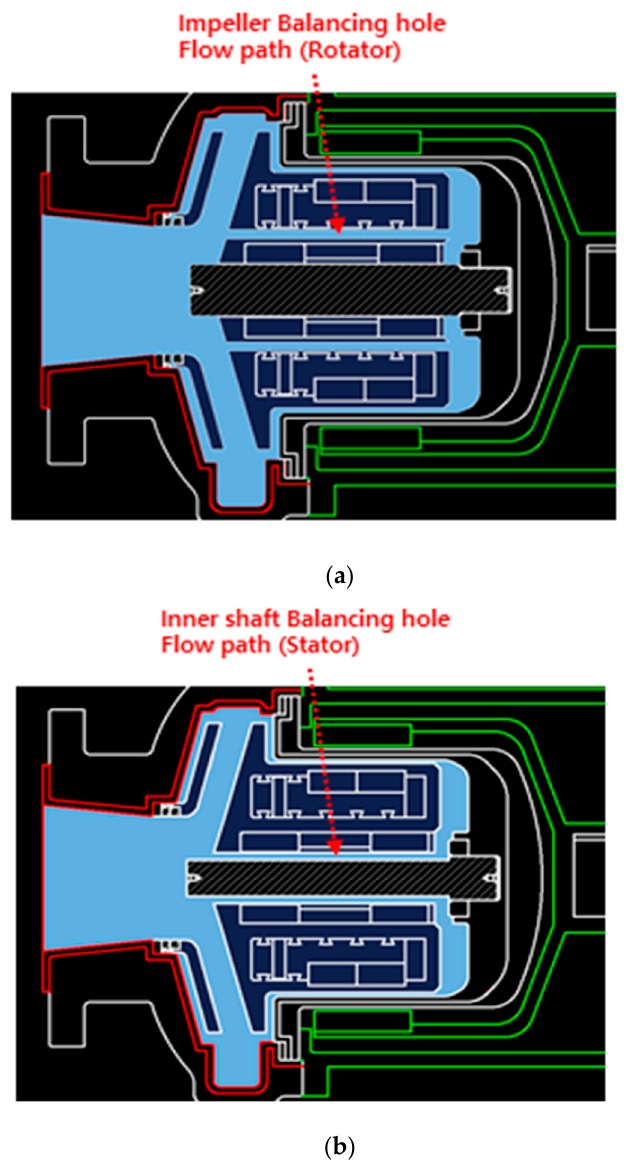
Figure 2. 2D cross-section diagrams of the pump with two types of balancing holes: ( a ) Type A pump with balancing holes in the impeller; ( b ) Type B pump with balancing holes in the outer wall of the inner shaft.